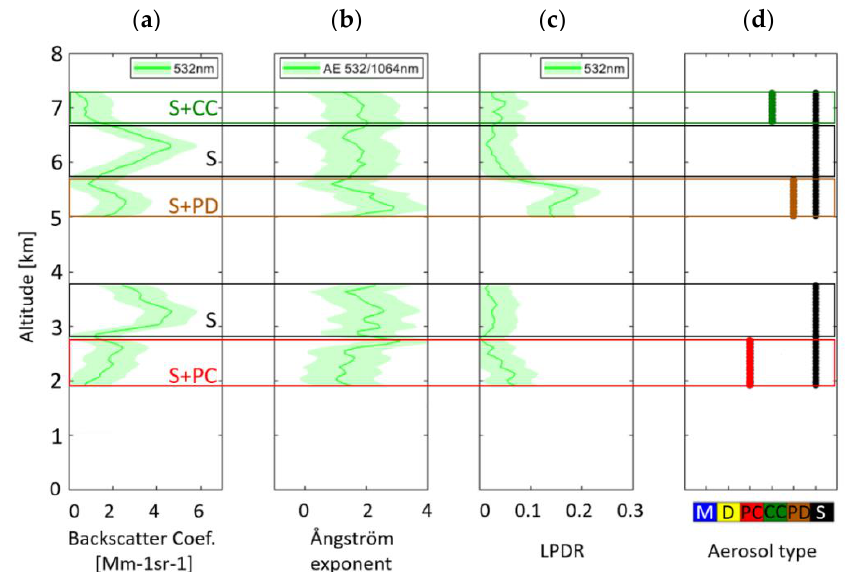
Figure 3. Vertically resolved aerosol optical properties: ( a ) β at 532 nm, ( b ) β -related AE 532 / 1064 nm, ( c ) LPDR at 532 nm and ( d ) aerosol typing according to the CALIPSO algorithm (M: marine, D: Dust, PC: Polluted Continental, CC: Clean Continental, PD: Polluted Dust, S: Smoke), as retrieved from the nighttime CALIOP orbit on 20 August. The coordinates used to derive these properties were 42.5 ◦ N and 73.8 ◦ W. Green shadowed lines correspond to the standard deviation for each aerosol